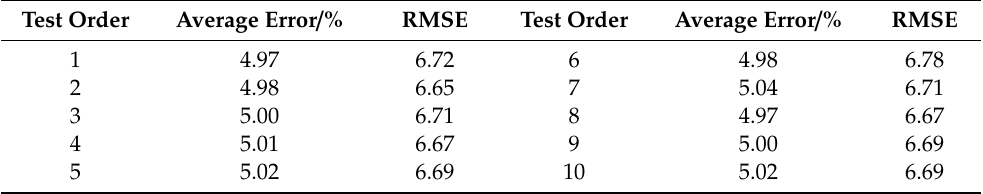
Table 4. Prediction results of the proposed